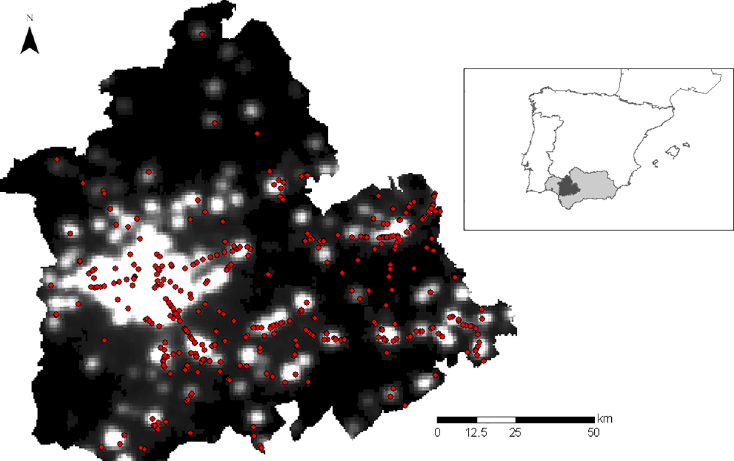
Fig 5. Distribution of dog-vehicle collisions in relation to night-light levels. Night-light levels were used as a proxy of the distance to urban areas (see main text for further details) in Seville. Black color indicates points without night- light, whereas white color shows points with the highest night-light levels. The inset map indicates the location of Seville (dark grey area) and Andalusia (light gray area) is Spain.